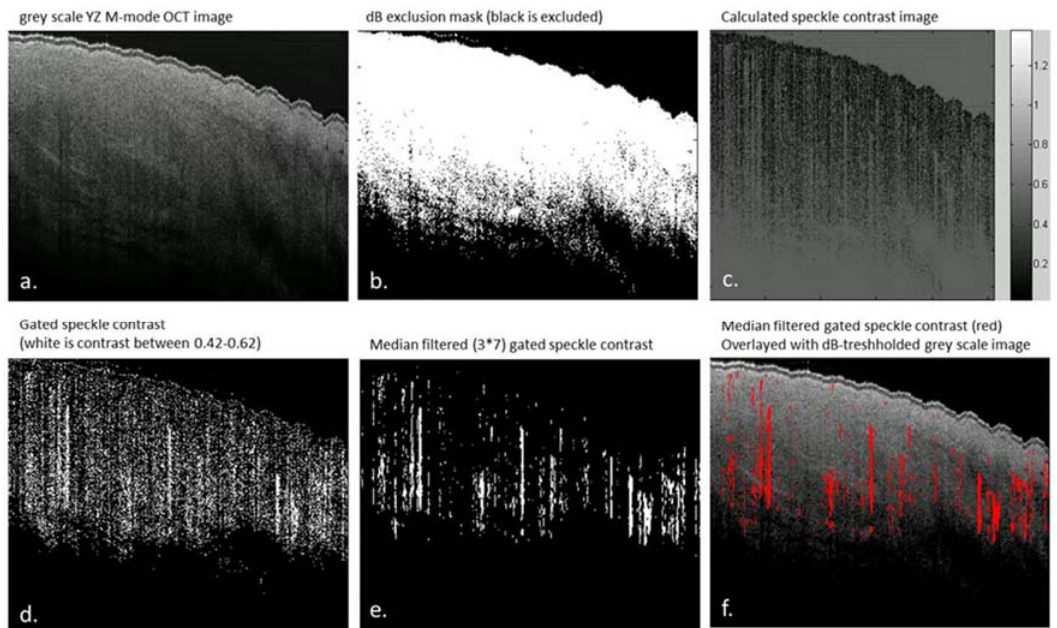
Figure 3. Data analysis steps of OCT M-mode scans, all images are shown from the y-z plane. ( a ) grayscale y-z M-mode scan; ( b ) applied dB mask to exclude noise from the data, the white areas on this image are included as data ( c ) over the time scale calculated speckle contrast values (of regions of included data after the dB threshold ( d ) speckle contrast within the 0.42–0.62 gate plotted in white ( e ) speckle contrast after applying a median filter with a 7 × 3 pixel kernel ( f ) gated and filtered speckle contrast (red) overlaid with the grayscale OCT image.